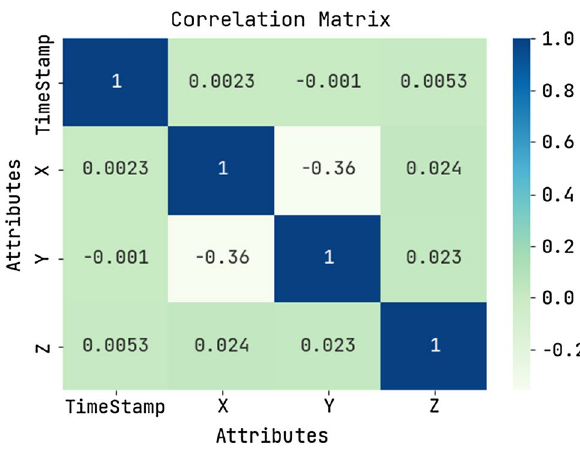
Fig. 3 Confusion matrix of CICC-BDVMR technique on localization